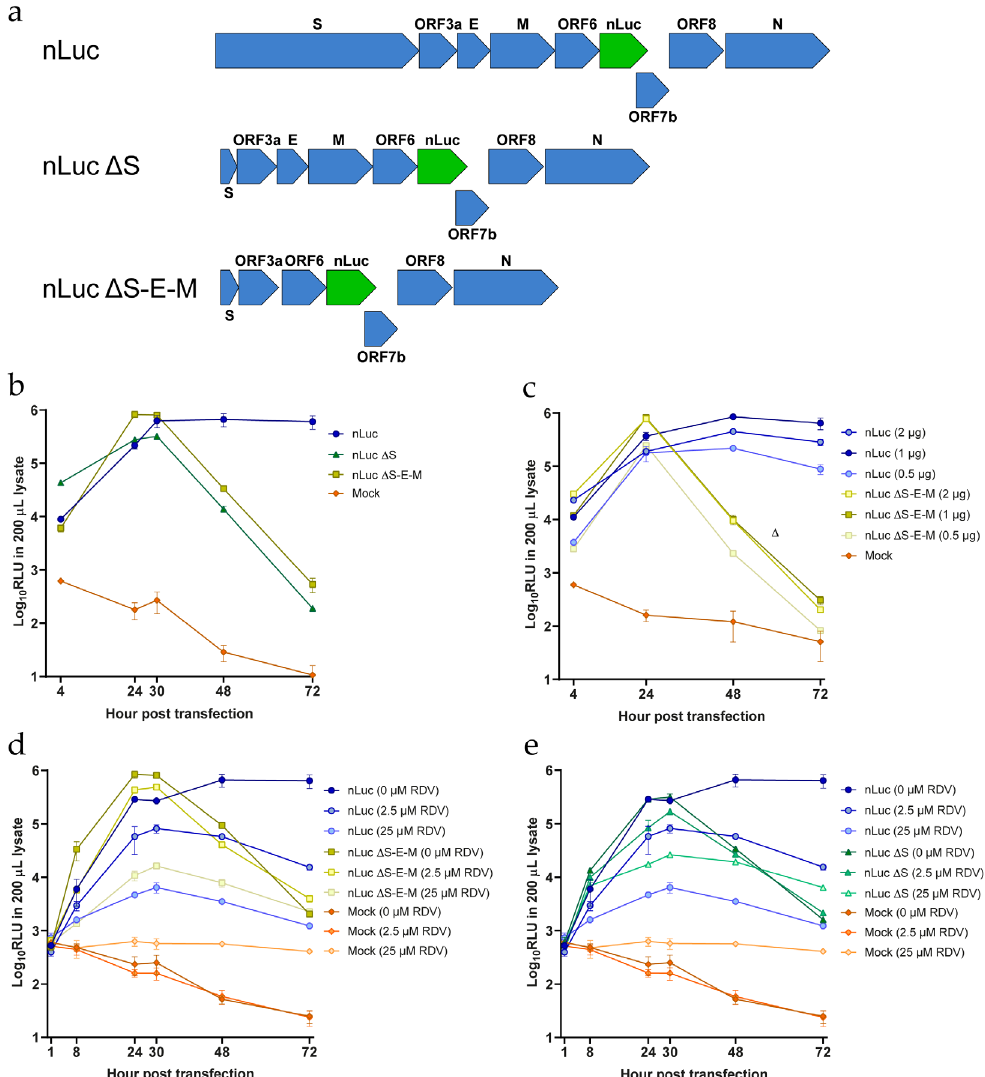
Figure 5. Generation of SARS-CoV-2 subgenomic replicon systems. ( a ) Structure of the replicon constructs, with the nLuc ORF7a insertion highlighted in green. ( b ) Luciferase activity of the different replicons after transfection with 2 μ g of RNA. ( c ) Luciferase activity after transfection with different amounts of RNA transcripts. ( d , e ) Luciferase activity of the different SARS-CoV-2 nLuc systems under treatment with remdesivir (RDV) at various concentrations. Remdesivir was added 32 h prior to transfections and re-applied 1-h post transfection. Mock, transfection without any RNAs. The datapoints represent the mean of three independent transfections. Each transfection was performed in triplicate, and the mean of each transfection was used to calculate the values shown here; error bars represent standard errors of the mean. For some data points the differences are too small to plot error bars.